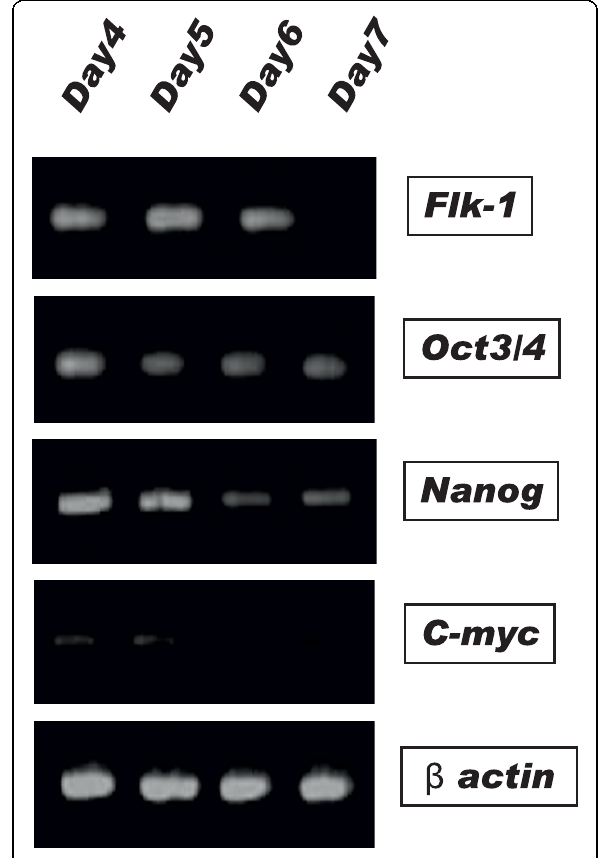
Figure 3 Time course RT-CPR in vitro . The expression of Flk-1 was peaked at Day5 from differentiation. Undifferentiated iPS cells markers, Nanog and Oct3/4, were strongly expressed in early phase and started to gradually decrease with differentiation. We also observed the transient expression of c-myc at Day4 and